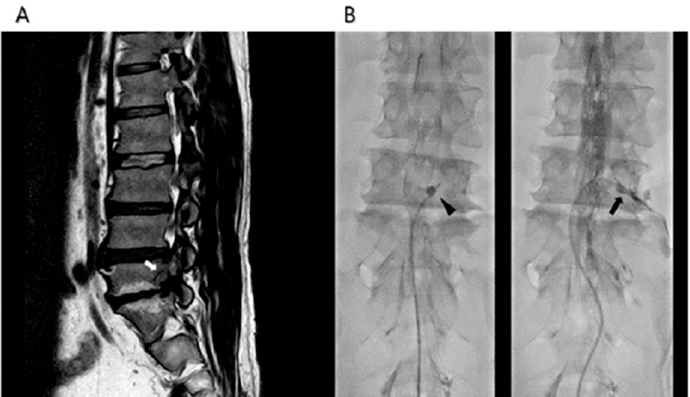
Figure 1. Percutaneous epidural adhesiolysis combined with balloon decompression in a patient with right L5-S1 foraminal stenosis. ( A ) A lumbar magnetic resonance image of a 59-years- old man with right lower extremity neurogenic claudication shows a moderate grade of stenosis in the right L5-S1 lumbar foramen (white arrow). ( B ) Anteroposterior fluoroscopic view showing the inflatable balloon neuroplasty catheter placed in the right L5-S1 intervertebral foramen and the balloon filled with the contrast medium (black arrow head). Foraminal stenosis is visualized by the degree of balloon distortion (black arrow).